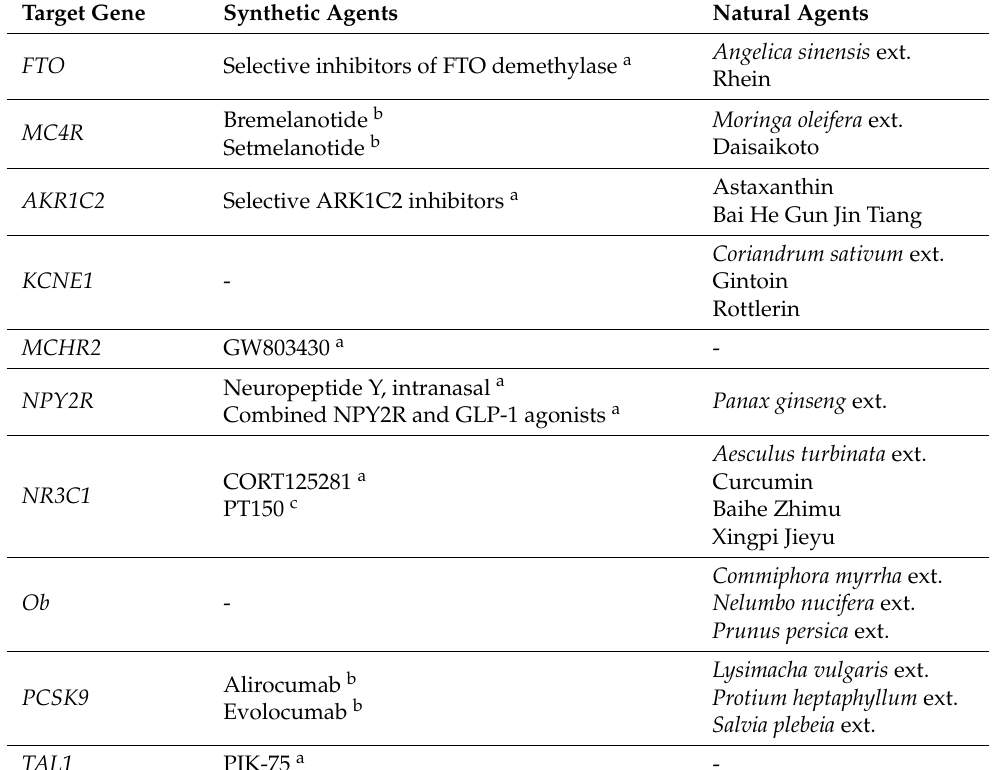
Table 3. Potential pharmacological therapies for comorbid obesity and depression, based on genetic